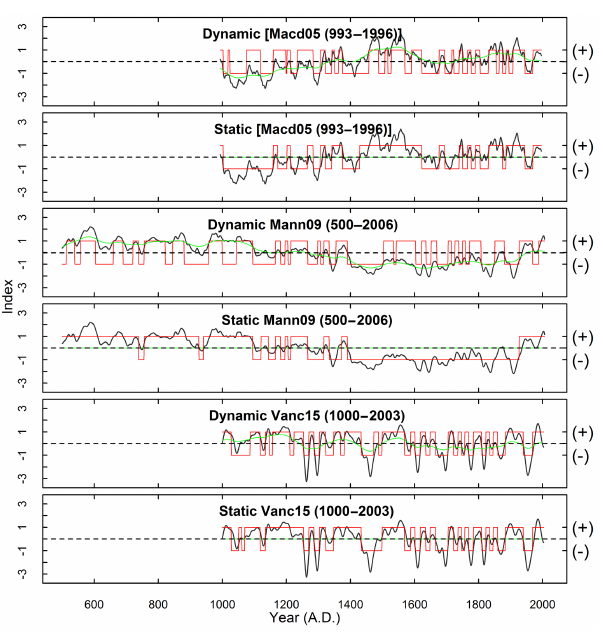
Figure 2. Run length time series extracted using the dynamic and static threshold methods for reconstructions with centennial